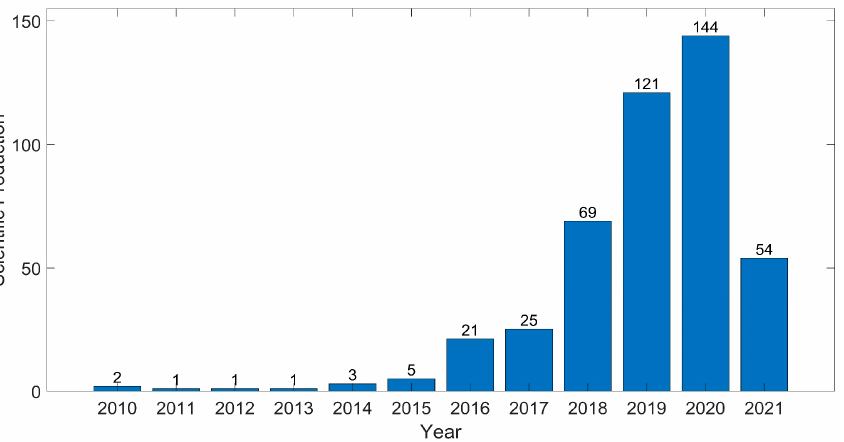
Figure 1. Number of scientific productions between 2010 and 2021 for the keywords “cyber-physical system” and “artificial intelligence”.